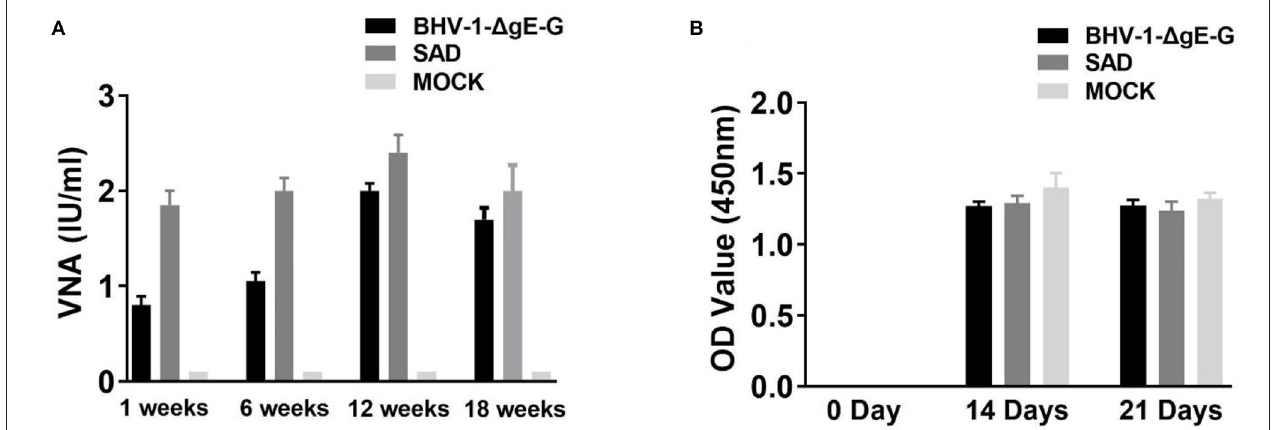
FIGURE 5 | VNA level of cattle immunized with BHV-1- 1 gE-G via IM route. (A) Five cattle immunized with a single dose of 10 7 PFU of BHV-1- 1 gE-G, 10 7 PFU of SAD, or DMEM. Serum samples were collected at 1, 6, 12, and 18 weeks and subjected RFFIT for VNA analysis. (B) Serum samples were collected on 0 day, 14 days, and 21 days and performed ELISA for gB antibody for